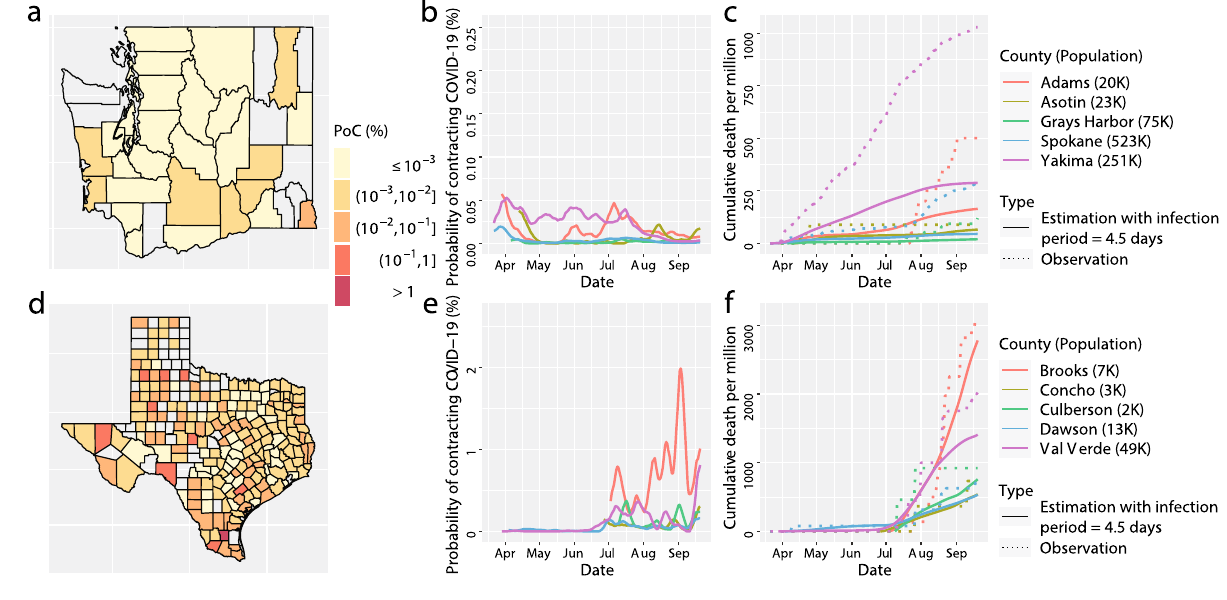
Figure 11. ( a – f ) The simulated results of COVID-19 progression characteristics in Washington (the first row) and in Texas (the second row) that have the same interpretation as ( a – f ) in Fig. 4 with the infection period changed from 5 to 4.5 days, whereas other parameters are held the same.